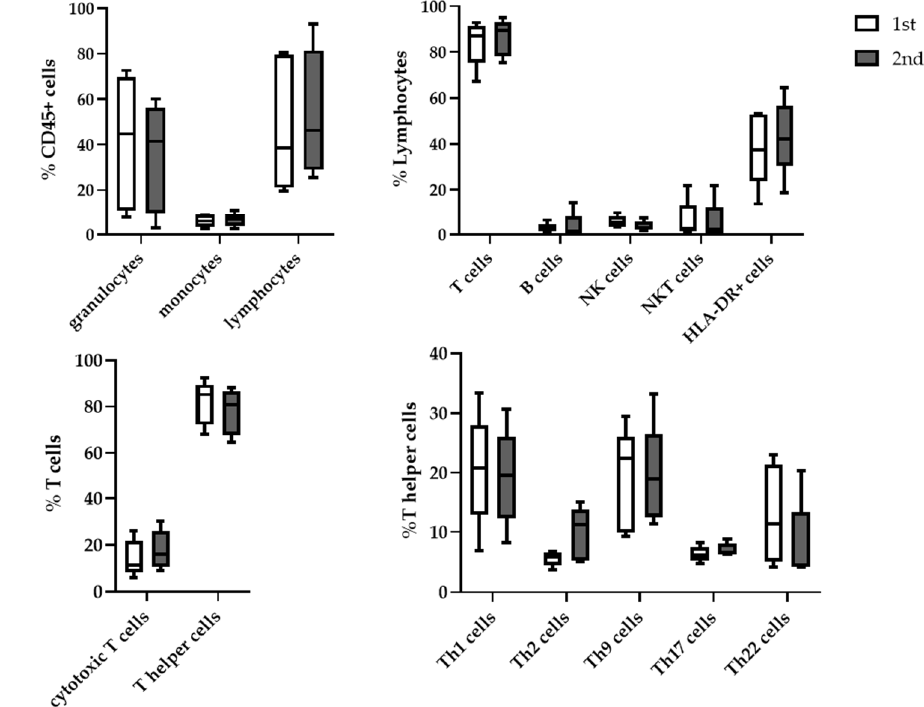
Figure 4. Comparison of all leucocyte subpopulations between first and second fine-needle aspiration.